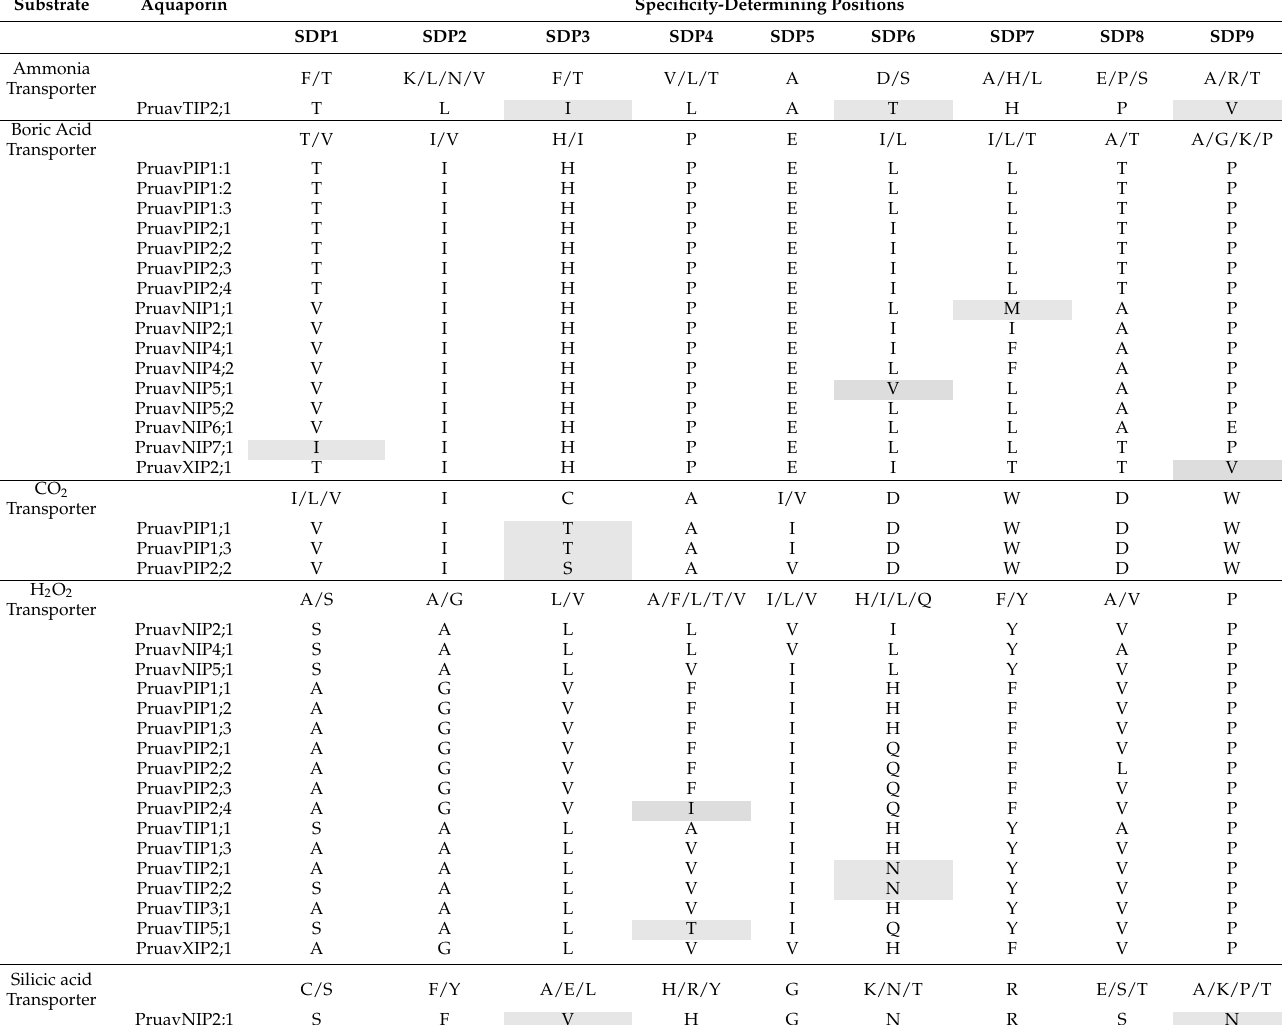
Table 2. Functional inference based on the specificity-determining positions analysis of sweet cherry aquaporins. Differences in residues are marked with